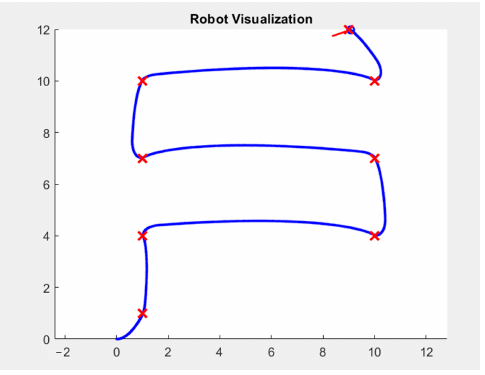
Figure 13. Robot movement simulation results. Visualization of robot movement using four meters distance between lines.